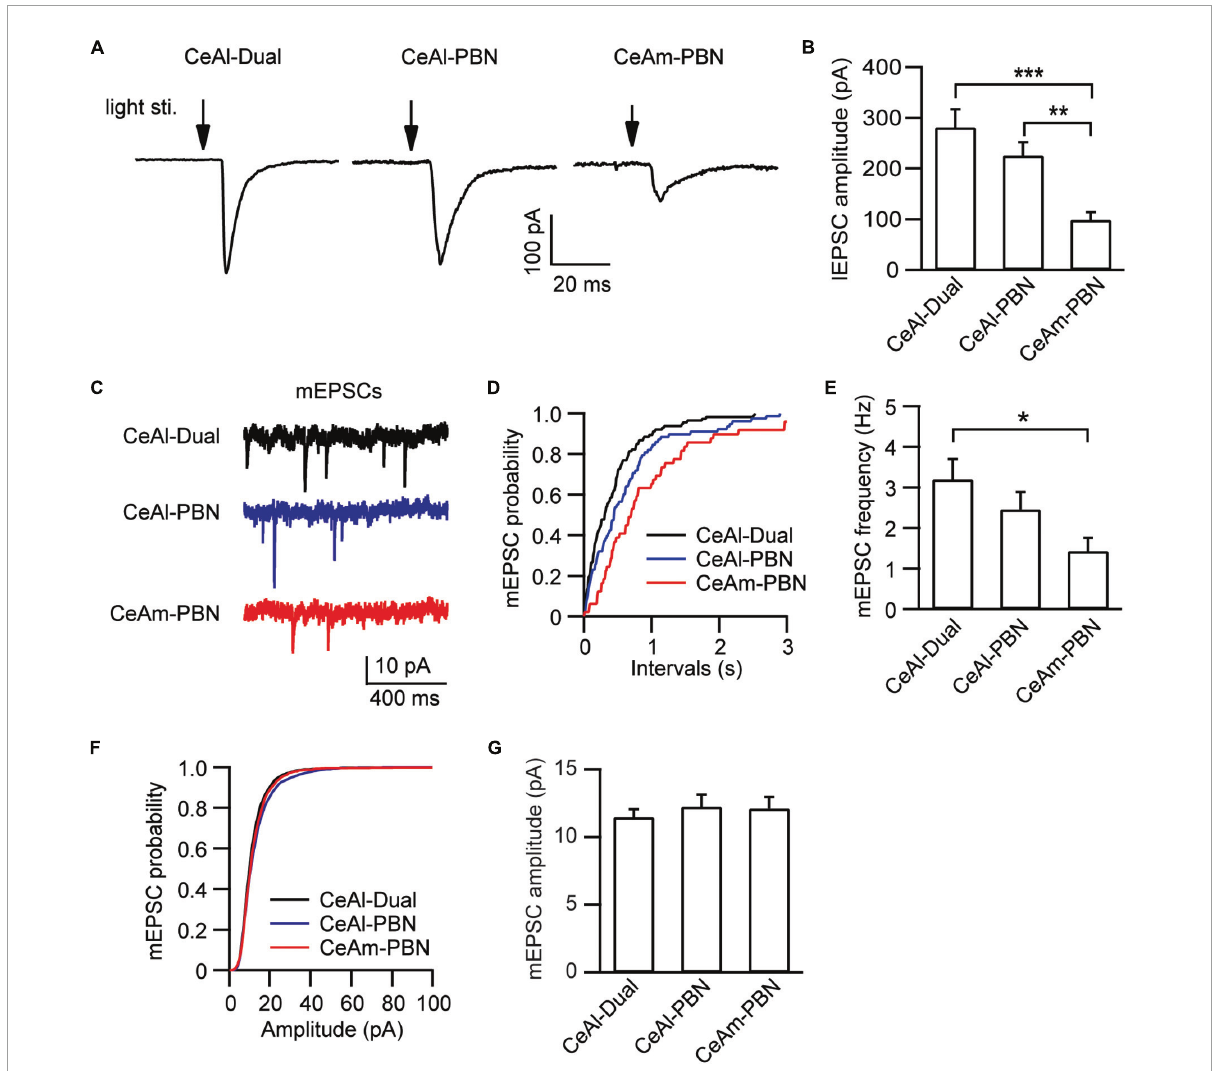
FIGURE5 Synaptic strength is stronger in PBN–CeAl synapses than in PBN–CeAm synapses in naïve rats. (A,B) lEPSC traces (A) and group data of lEPSC amplitude (B) in dual-input cells and PBN-input-only cells in CeAl, and in PBN-input-only cells in CeAm. (C–G) mEPSC traces (C) and group data of mEPSC frequency (D,E) and mEPSC amplitude (F,G) in the 3 cell types in CeAl and CeAm. * p < 0.05, ** p < 0.01, and *** p < 0.001.